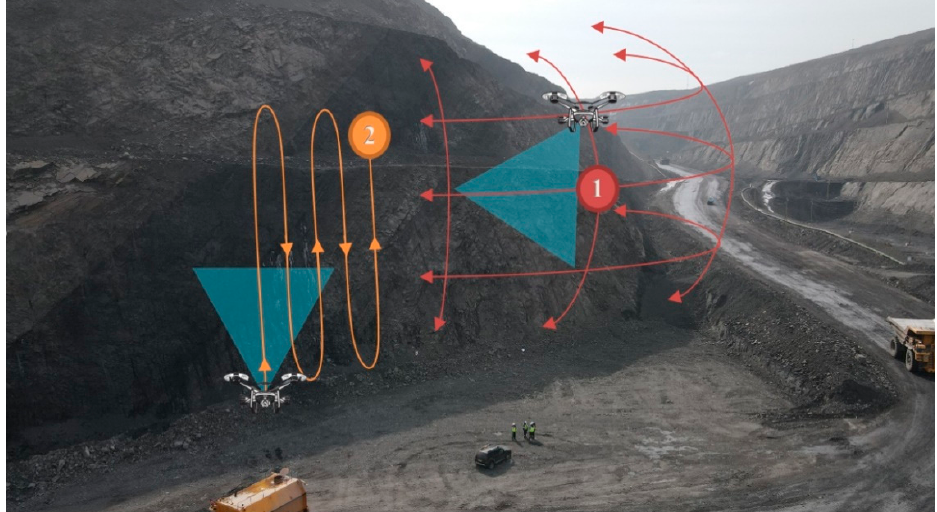
Figure 6. Patterns of scanning boreholes No. 469–483 of the pre-split row in the block No. K 67–78. in level +120.0–+121.0.